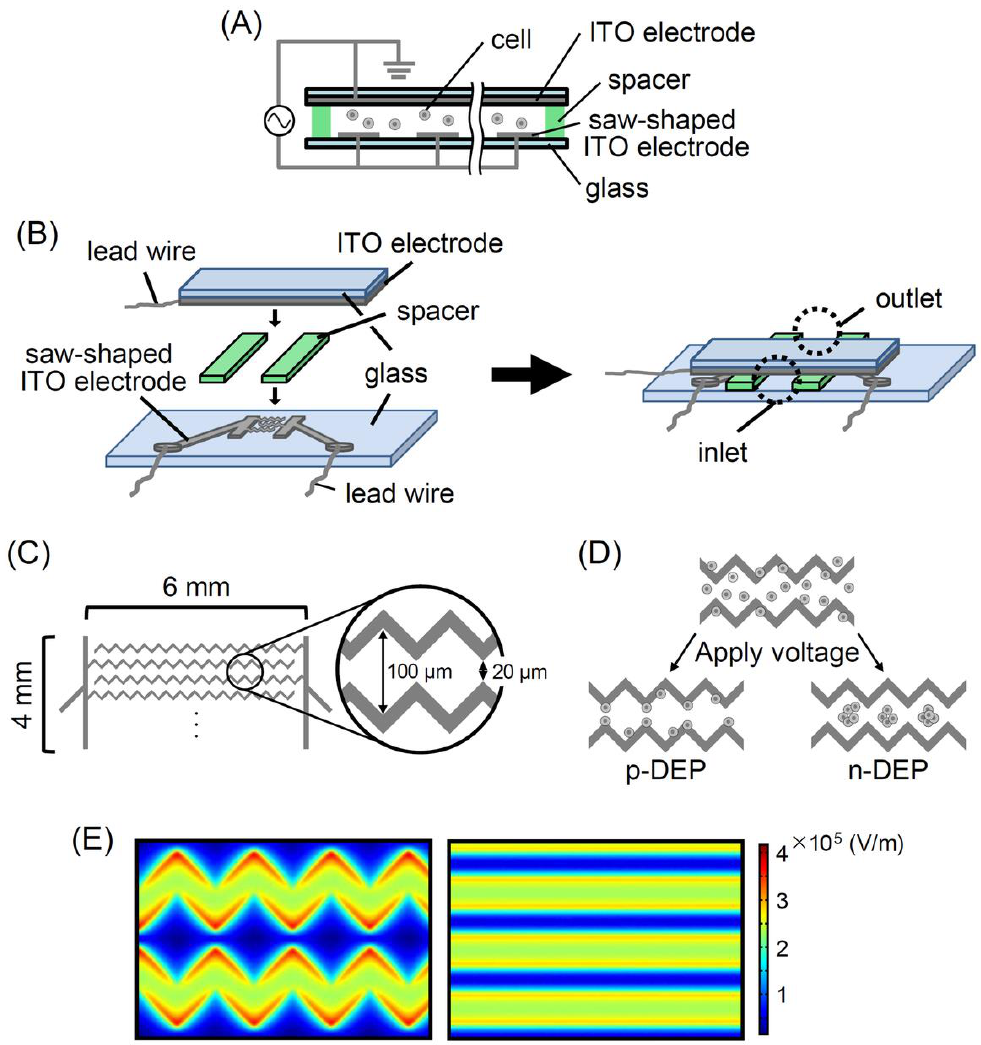
Figure 1. Structural overview of the dielectrophoresis (DEP) device. Schematic diagram of ( A ) cross- section and ( B ) bird’s eye view of the dismantled and constructed DEP devices. ( C ) Saw-shaped indium tin oxide (ITO) electrode printed on the bottom of the DEP device. ( D ) Illustration of p-DEP and n-DEP on the saw-shaped ITO electrode in the device. ( E ) Numerical simulation of electric field strength on (left) the saw-shaped ITO electrodes and (right) the line-shaped ITO electrodes by the finite element method (FEM). The potentials on the electrodes were set to 10 V. The height of calculated x-y plane is 4 μm from the bottom and scale bar represents 100 μm.